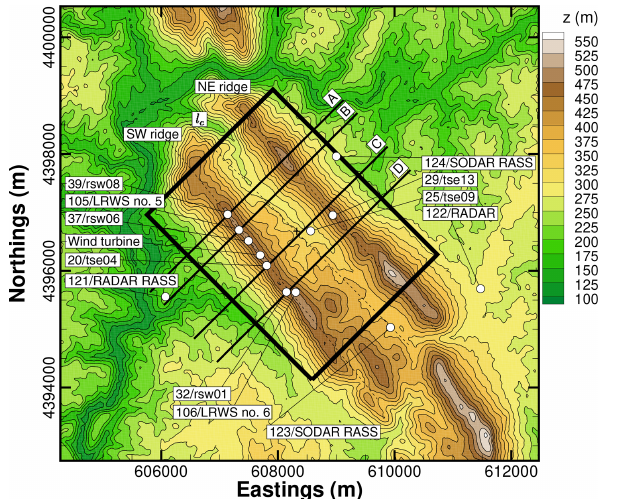
Figure 3. Area of interest and transects (ED50 UTM 29N).